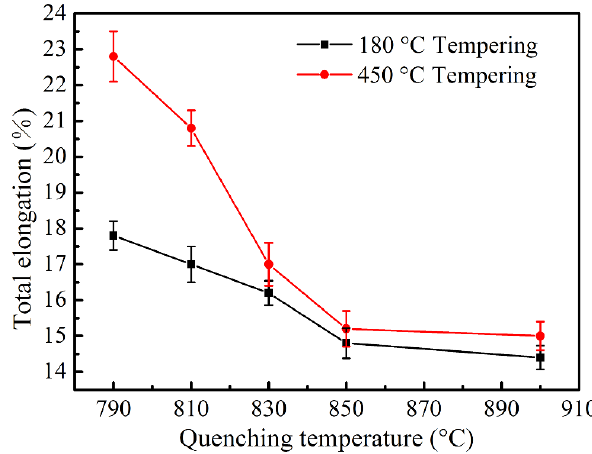
Figure 6. Total elongation as a function of quenching temperature tempered at 180 °C and 450 °C, respectively.